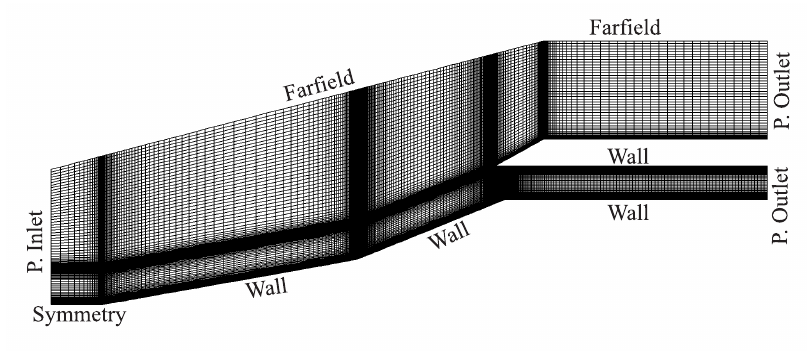
Figure 10. Medium mesh for the baseline case.